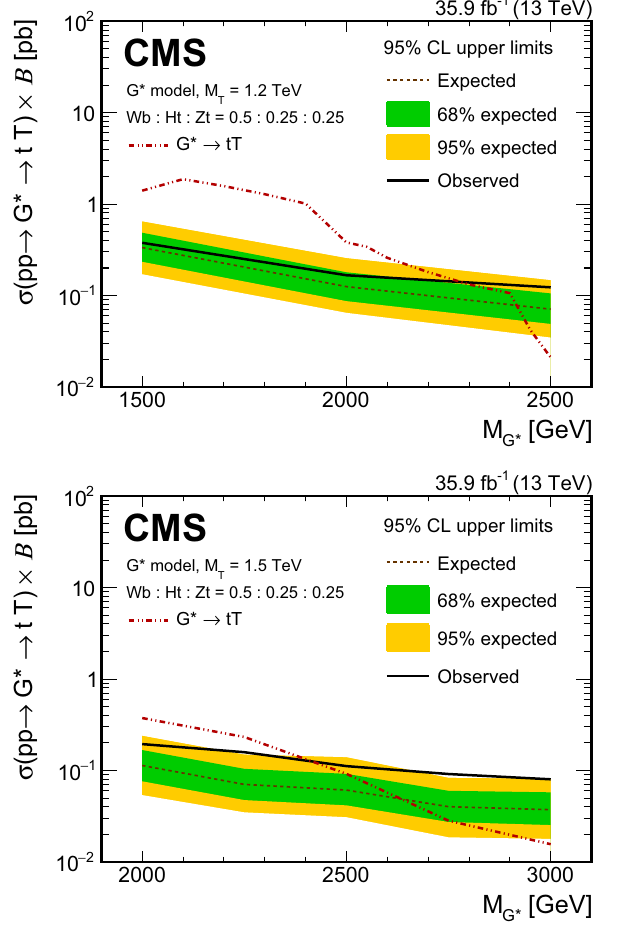
Wb ) + B ( T → Ht ) + B ( T → Zt ) . Observed and expected limits are compared to the predictions from two different theory benchmark mod- els: the G ∗ model (upper left and lower row), and the left-handed ρ L in the ρ 0 model (upper